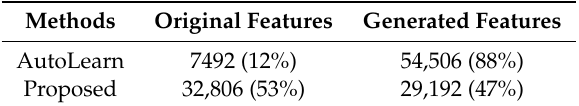
Table 6. The total number of features generated by each method for the 13 test datasets.